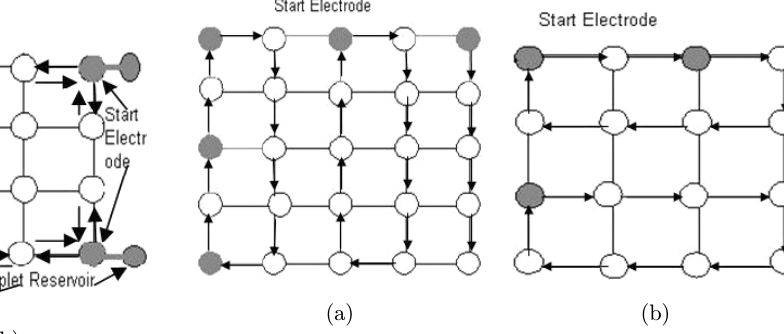
Fig. 5. Loop formation and traversing droplet in clockwise